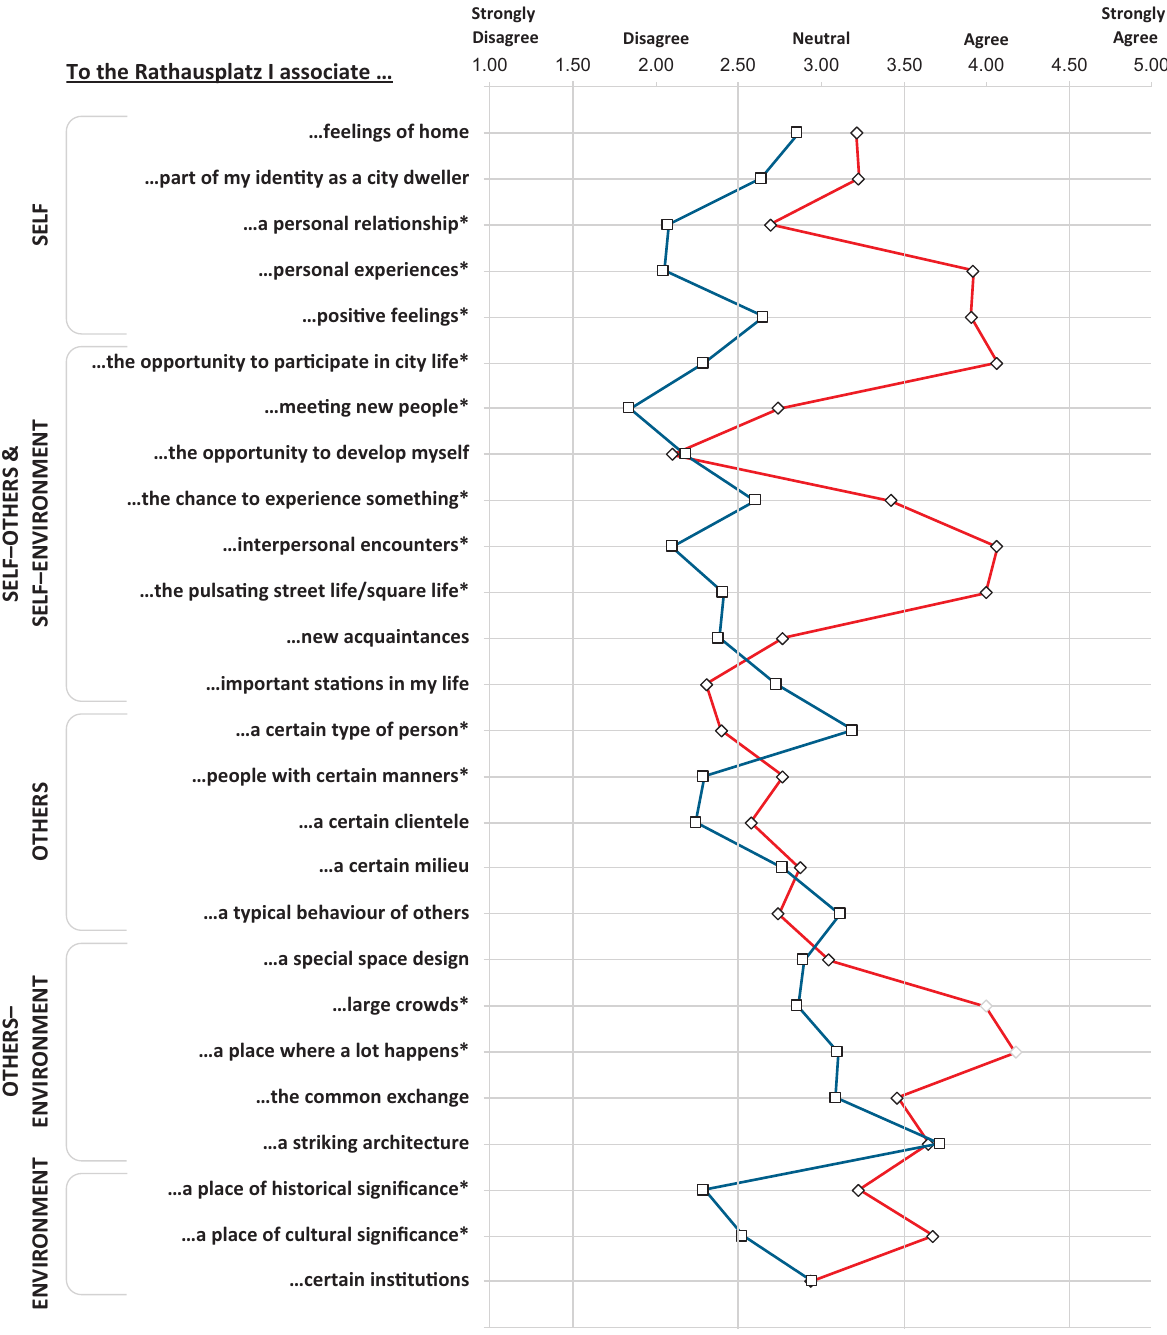
Figure 3. Augmented (blue) and non‐augmented (red) spatial meaning. Note: * = mean comparison significant. 5 = strongly agree ). Using comparisons of means in con‐ nected samples, we tested this empirical tool to measure augmented spatial meaning for statistical